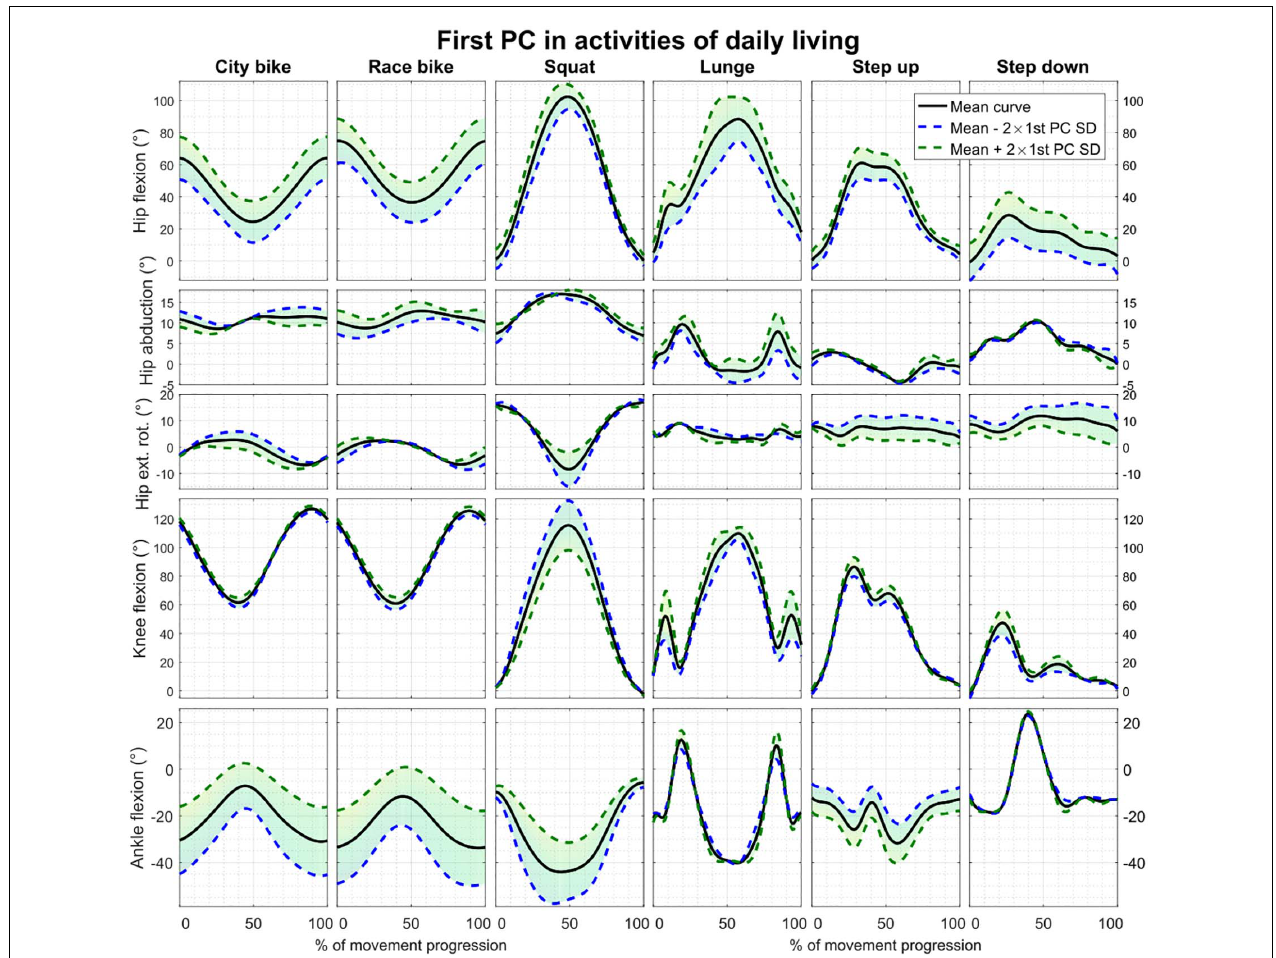
FIGURE 2 | First principal component of all the parameterized kinematic models based on PCA. Model training curves were first aligned by means of CR. The black line depicts the average motion curve, while the green and blue dashed line represent 2 standard deviations (SD) of the first kinematic mode.